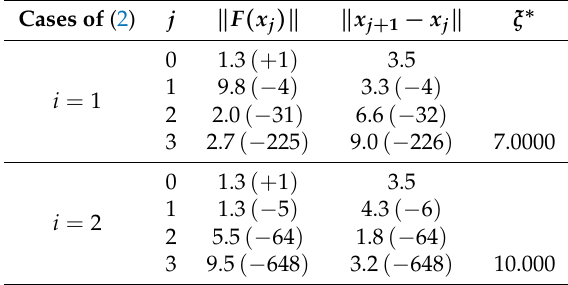
Table 7. Computational results on Example